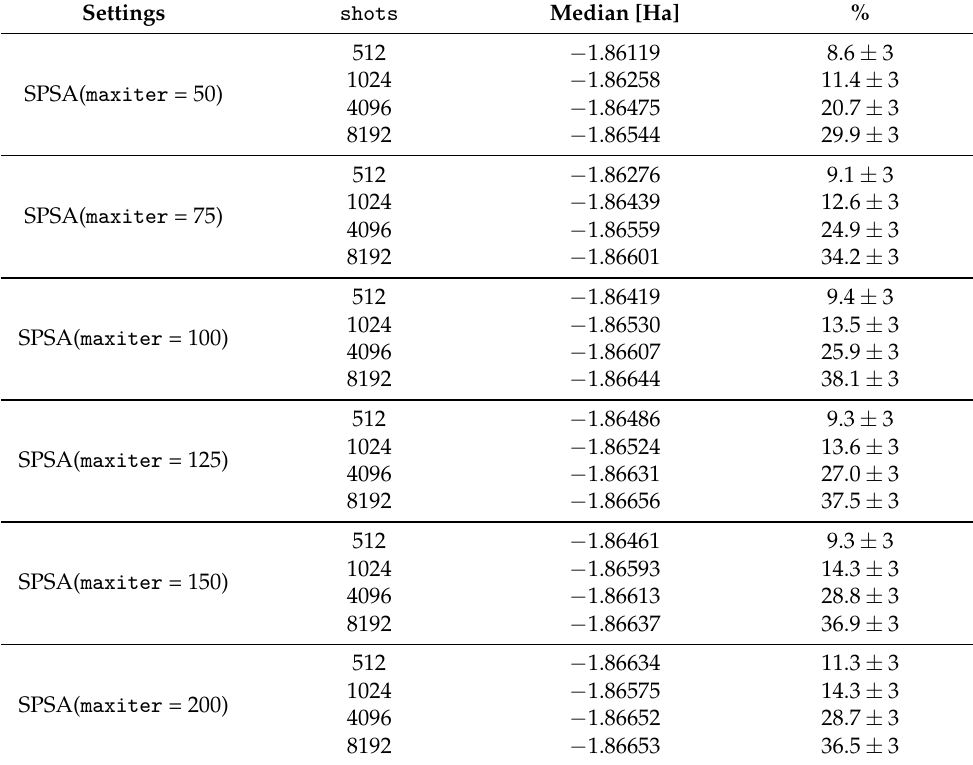
Table A2. Summary of the medians of 1000 optimized ground-state energies and the percentage of outcomes that were found within chemical precision of exact energy ( − 1.86712 ± 0.0015 Ha) for different settings for the maximum number of iterations ( maxiter ) and number of shots. The R y variational ansatz was used. The error margin of 3 percent was estimated based on the standard deviation of 1000 identically distributed trials. These data are the basis for Figure